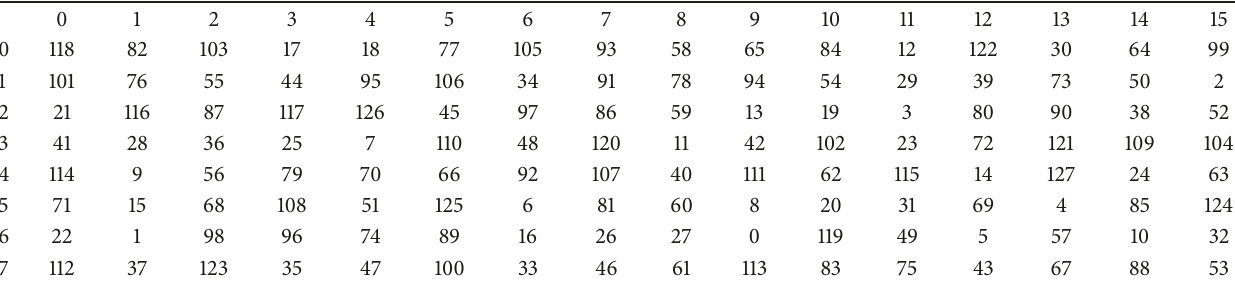
Table 5: The proposed 7 × 7 substitution-box.